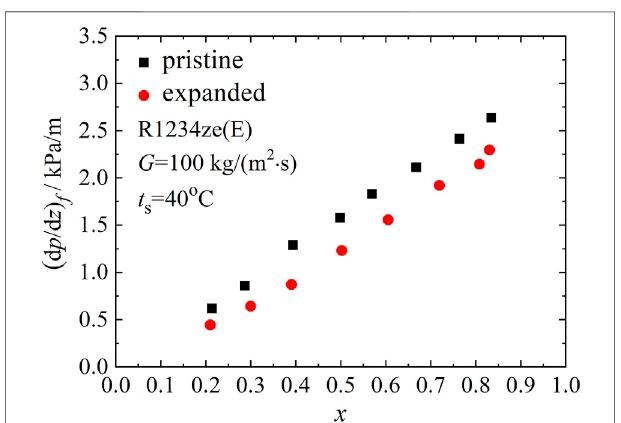
FIGURE 10 | Effect of tube expansion on friction pressure gradients at 200 kg/(m 2 · s).